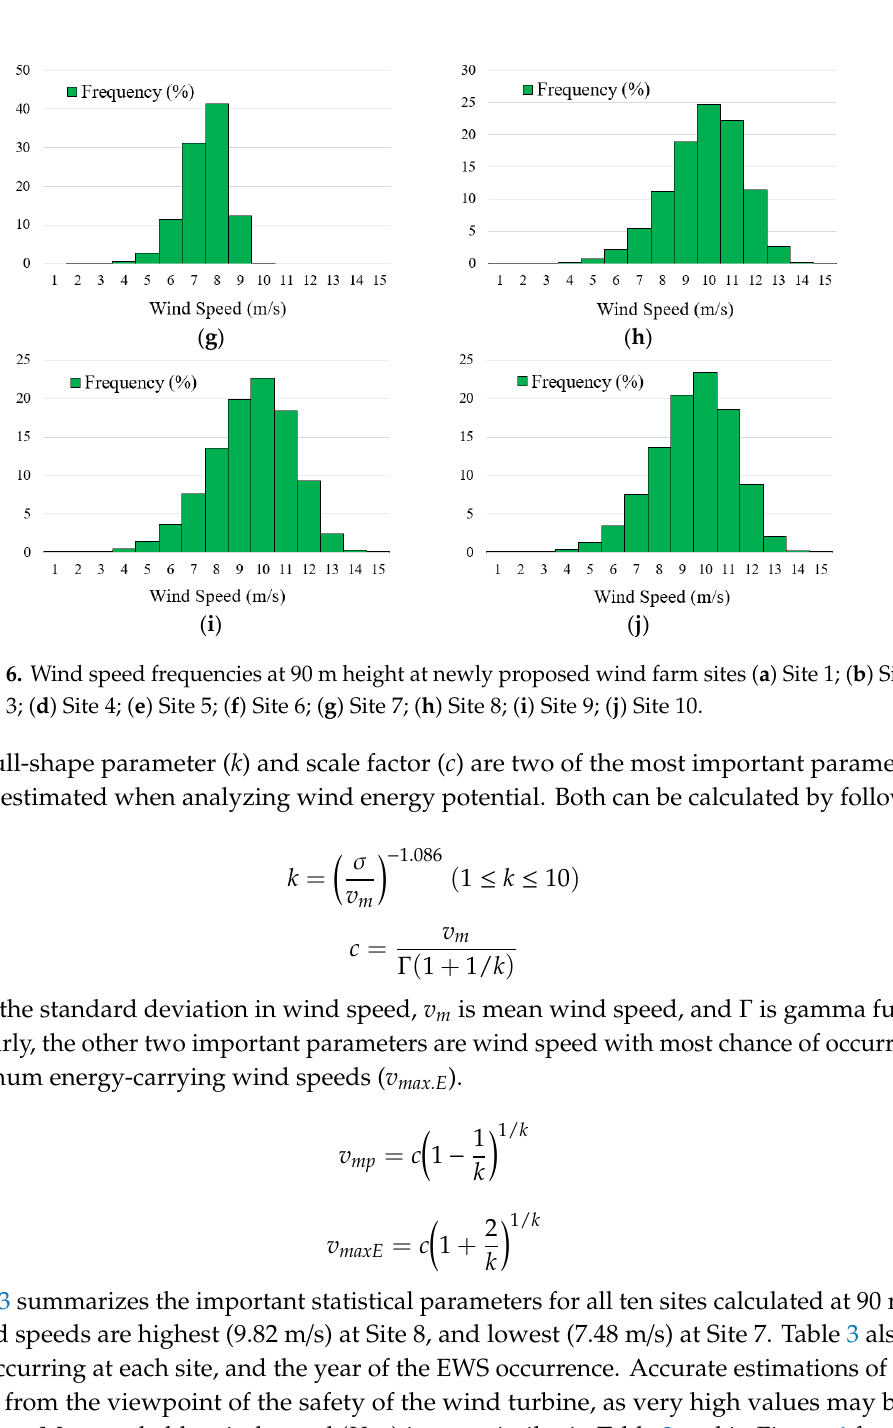
Table 3. Wind characteristics at newly proposed onshore wind farm sites (90 m height).